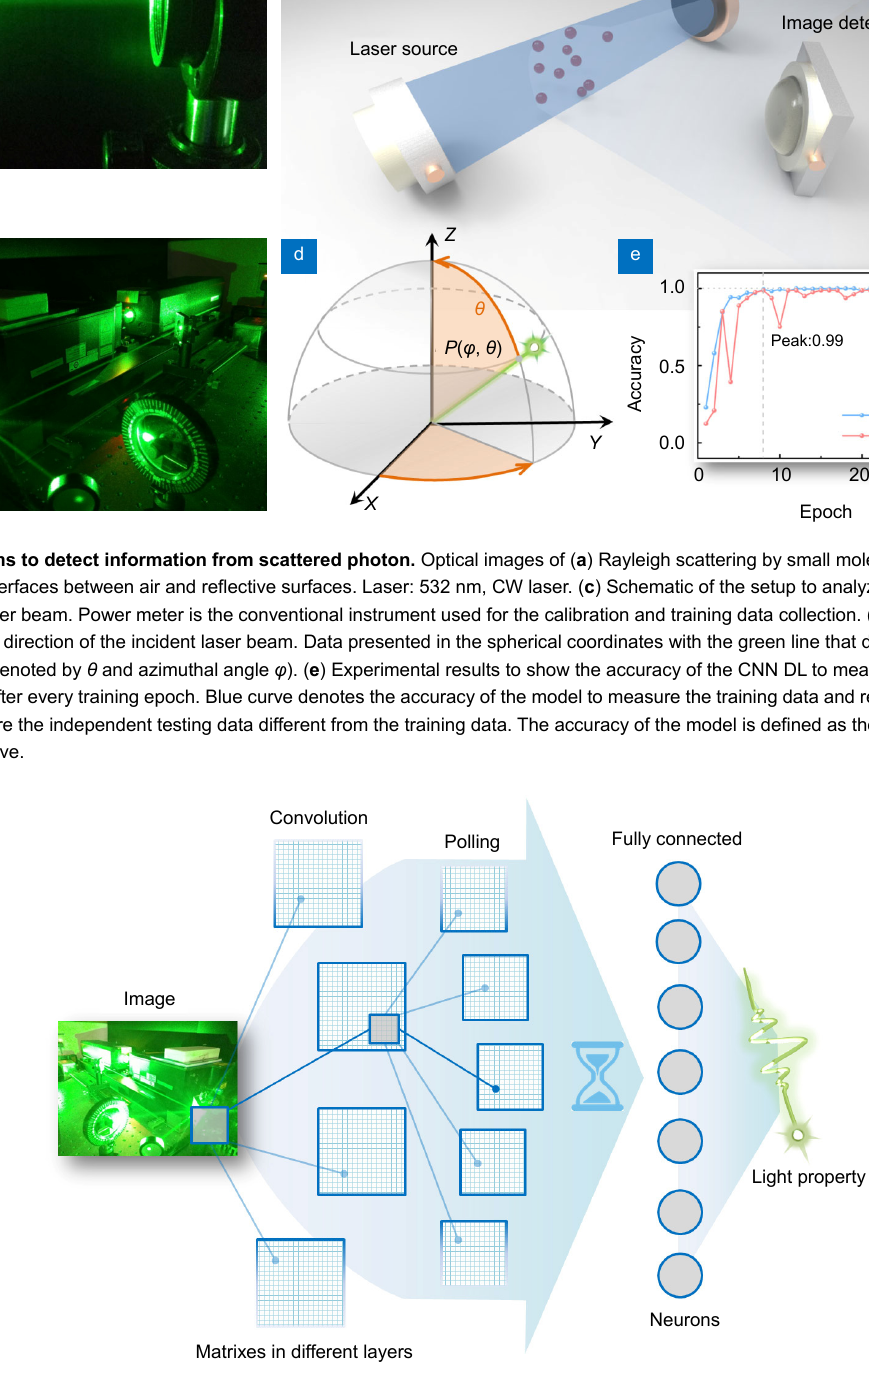
Fig. 2 | Schematic illustration of the convolutional neuron network. The details of the pre-processing, architecture, and parameter settings are described in the supplementary materials. For this neuron network, the input is a 150×150×3 image pre-processed from optical images taken from a CMOS. A 2 layers’ convolutional network, 1 fully connected layer and one output are used to calculate the light properties of